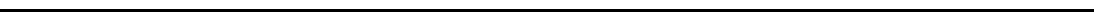
Fig. 1 PKA- and GRK-p β 2 ARs are spatially segregated on the plasma membrane. a , b SIM imaging shows total β 2 ARs, and PKA- and GRK-phosphorylated β β β fi c antibodies, respectively, in HEK293 2 ARs, which were stained with anti-FLAG, anti-S261/262 (PKA-p 2 AR), and anti-S355/356 (GRK-p 2 AR) speci cells expressing FLAG-tagged β 2 AR before stimulation ( a ) or after 30 s of stimulation with 1 μ M ISO ( b ). Scale bar, 2 μ m. Representative of n = 5, 4, 19, 11, and 13 cells, respectively, three independent experiments. c The overlap between two different staining from images in b was evaluated by Pearson ’ s correlation coef fi cient ( n = 19, 11, and 13 cells, respectively). d Quanti fi cation of two-color overlap was evaluated in HEK293 cells after 1 min of stimulation with 1 μ M ISO using the same method in b ( n = 13, 12, and 11 cells, respectively, three independent experiments). e FLAG- β 2 ARs expressed in HEK293 cells were stimulated with 1 μ M ISO for 30 s, and cell lysates were subjected to immuno-isolation with anti-pS355/356 (GRK-p β 2 AR) speci fi c antibody (1st immunoprecipitate, IP). The remaining β 2 ARs in the supernatant were isolated with anti-FLAG antibody (2nd IP). Total β 2 AR were immuno-isolated directly with anti-FLAG antibody (total IP). The β 2 AR in total IP and sequential IPs were resolved with SDS-PAGE, and probed with anti-FLAG, anti-pS261/262 (PKA-p β 2 AR), and anti-pS355/356 (GRK-p β 2 AR) antibodies, respectively. Representative of three independent experiments. Molecular weight markers (in kDa) are indicated on the left. Error bars denote s.e.m.; multiplicity adjusted P values are computed by one-way ANOVA followed by Tukey ’ s test